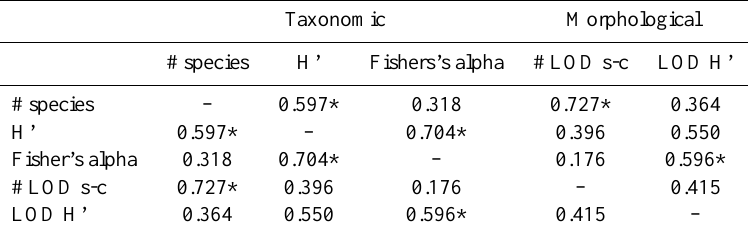
Table 4. Spearman rank correlation relationships (Rho values) among metrics of taxonomic and morphological diversity of tintinnids. For each station, estimates of taxonomic and morphological diversity were based on a pooled sample consisting of all individuals encountered in all samples from the station. Taxonomic metrics were numbers of species, the Shannon index, ln-based (H’) and Fisher’s alpha. Morpho- logical metrics were numbers of lorica oral diameters (in 4 µ m size-classes) and the Shannon index of the diversity of lorica oral diameters (LOD-H’), calculated by substituting size-classes for species (see methods for details). For all pairs, n =22; asterisks denote significant relationships ( p =.01). Note that measures of taxonomic diversity and morphological diversity co-vary positively.